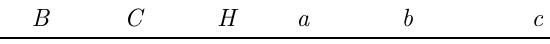
( l has been chosen according to the longest wavelength for the lowest frequency of 2 Hz). Elastic waves are excited at the top-left edge of the model by means of a unitary imposed displacement in the z -direction (red arrows in Fig. 2B). Two input signals are considered: (i) a triangular- like excitation (left panel of Fig. 2C) and (ii) a 15-cycle Hanning window modulated sinusoidal tone burst excita- tion (right panel of Fig. 2C), exhibiting a rather broad- band and narrow-band frequency content, respectively. perfect impedance match for pressure and shear waves, to avoid unwanted re fl ections. Symmetry conditions are applied to the left edge of the model in order to be consistent with the type of induced excitation.